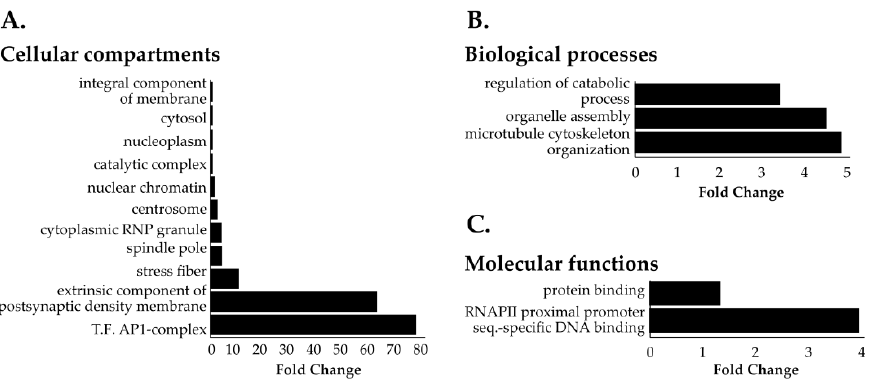
Figure 2. Gene ontology (GO) of NHA9-BioID proximal interactors. Most represented ( A ) cellular compartments (GOCC), ( B ) biological processes (GOBP), and ( C ) molecular functions (GOMF) among NHA9-BioID proximal interactors. Statistical analysis of the overrepresented proteins in the NHA9-BioID fraction (total 131 proteins) was performed with the PANTHER classification online software (v14.1) using Fisher’s exact test. Results are displayed for FDR p <